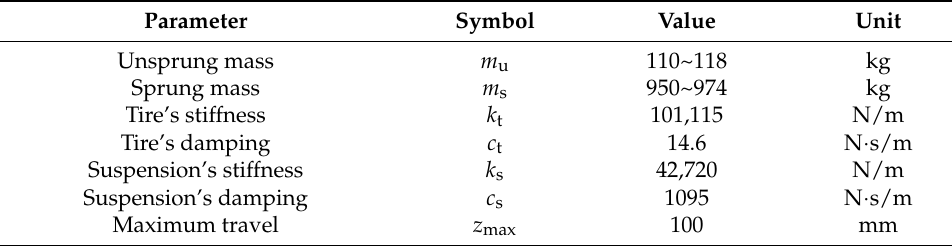
Table 1. The dynamics parameters of the suspension system.